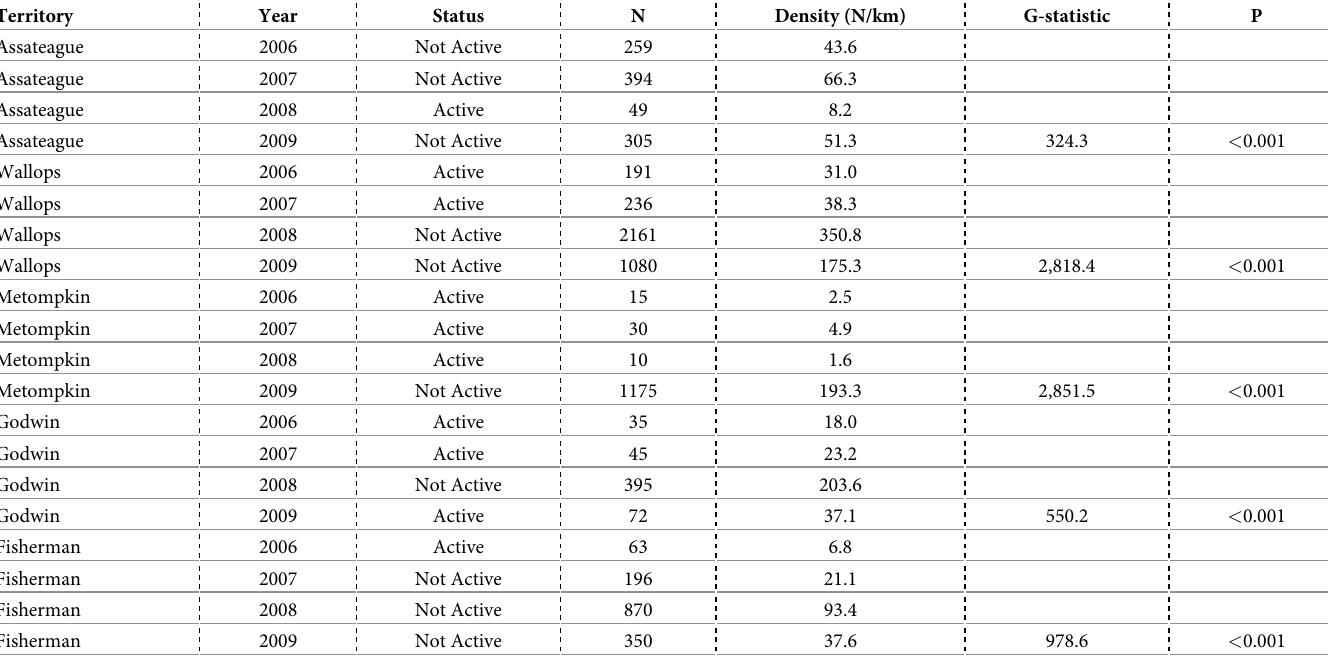
N refers to the number of red knots counted along beaches that were 0–3 km from falcon eyries. Status refers to whether or not the breeding territory was occupied during a given